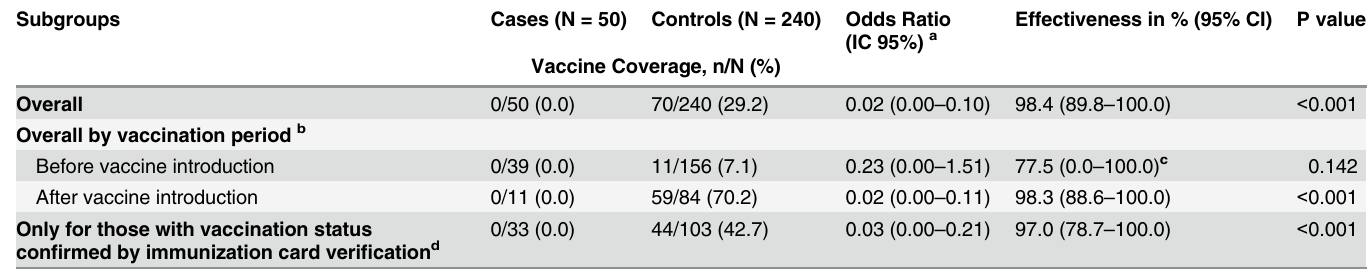
Table 4. MenC conjugate vaccine effectiveness and coverage among case and control subjects. Subgroups